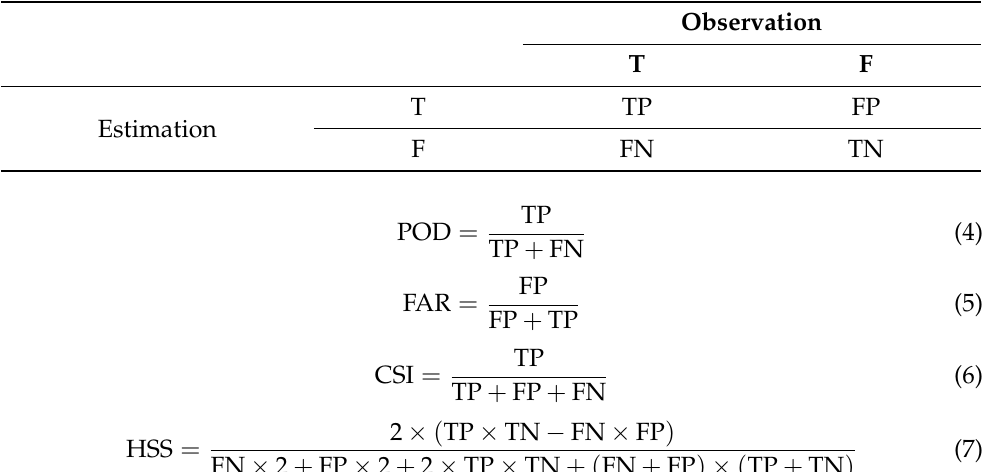
Table 2. Definition of classification index parameters.